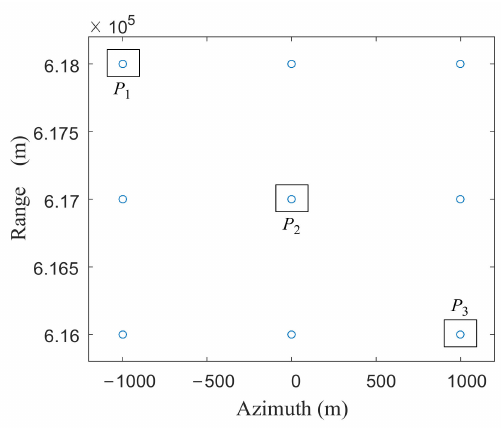
Figure 6. Lattice distribution of the point targets. After all the signals are received by three receiving satellites, the received signal of each satellite is separated into three sub-band signals by band-pass filter. Three sub-band signals can be separated from each satellite. Then nine sub-band signals can be separated from the three satellites. The schematic diagram of signal separation is shown in Figure 7.